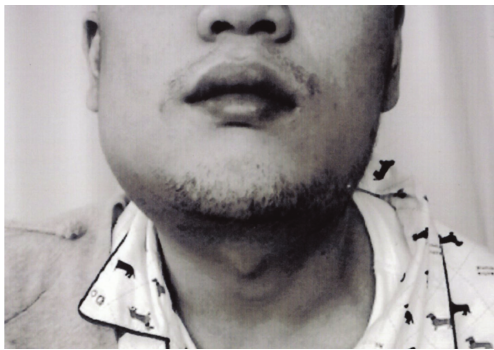
Figure 1: The photograph shows a mass protruding from the right neck.